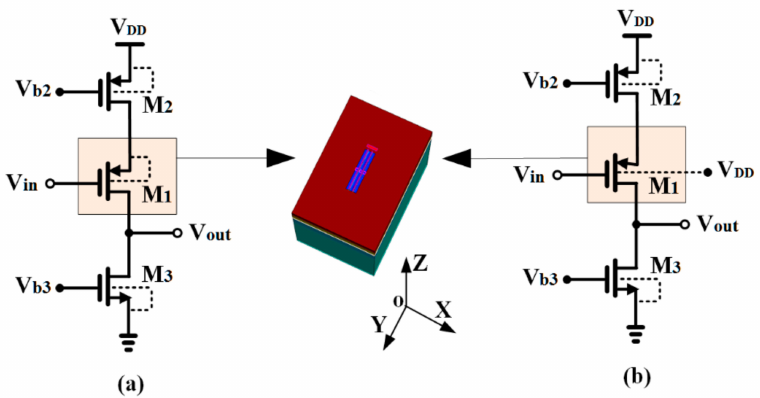
Figure 1. Mixed-mode simulations of the degenerated common source (CS)-amplifier. The struck transistor M1 is modeled with ( a ) well and source tied together (bulk tied to source (BTS) configuration); ( b ) well tied to V dd (normal